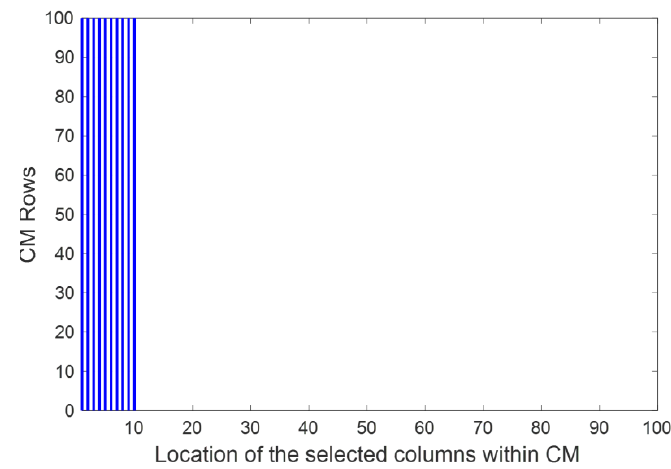
Figure 2. Conceptual diagram of selected columns in CM, using classical criterion, L= 9, M = 100, C = 10.